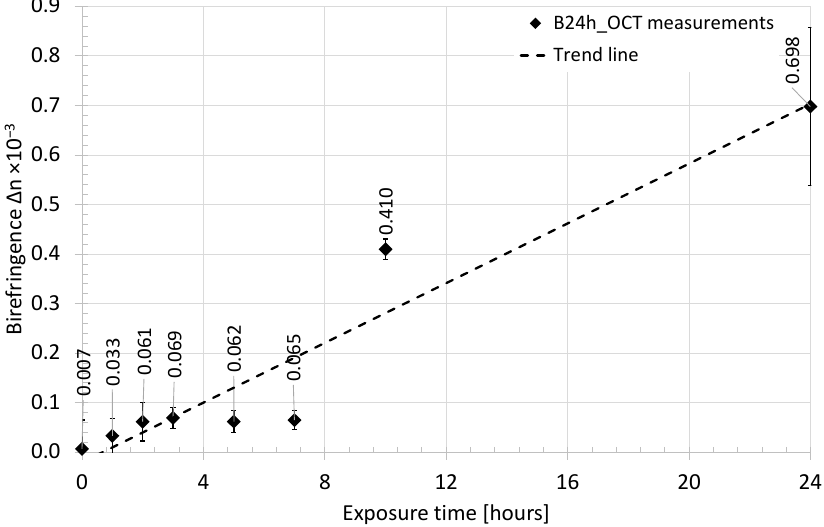
Figure 9. The average value of birefringence of the chicken humerus recorded in the first 24 h of exposure to acid—sample B24h_OCT.